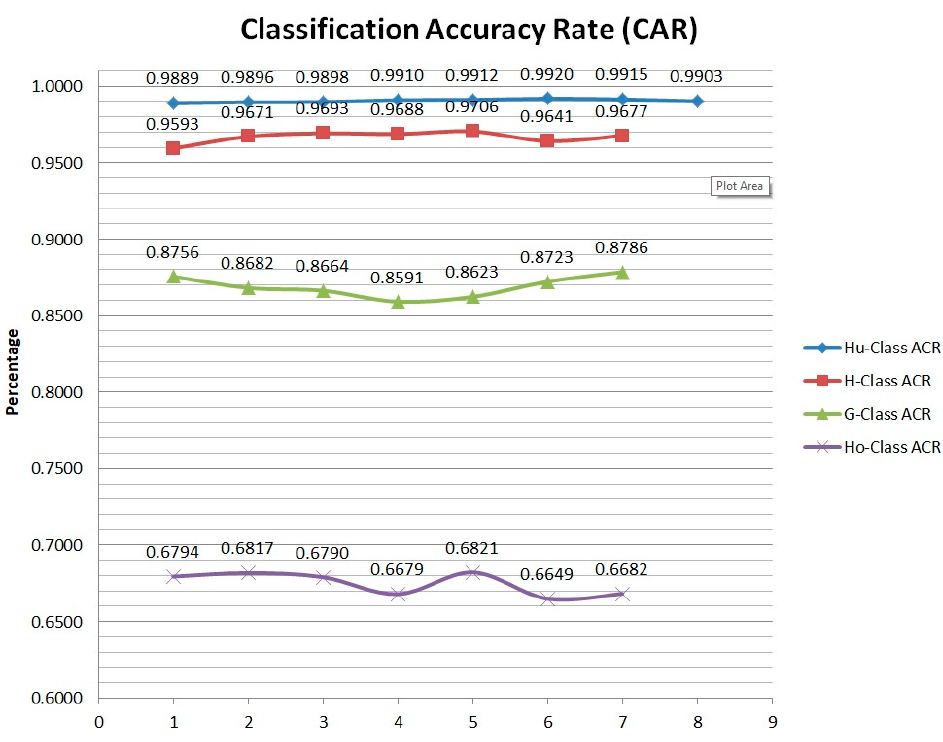
Figure 6. Classification rate of each class.